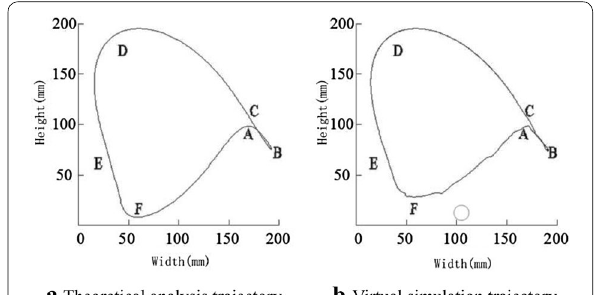
Figure 7 Trajectory comparison for the seedling pick-up mechanism